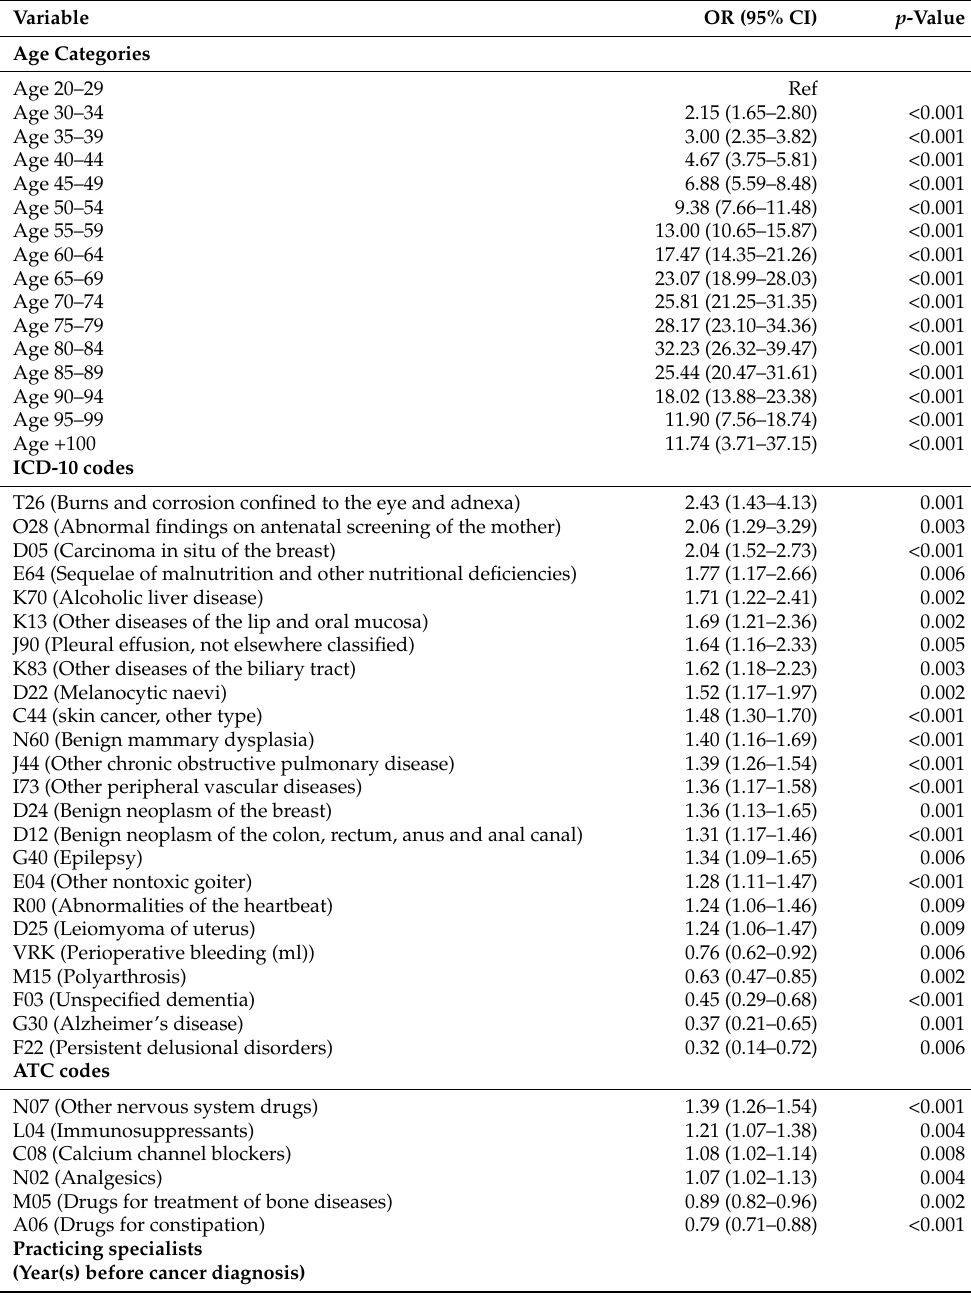
Table 2. Model A: Predictive risk factors in the development cohort with cancer as the out- come: